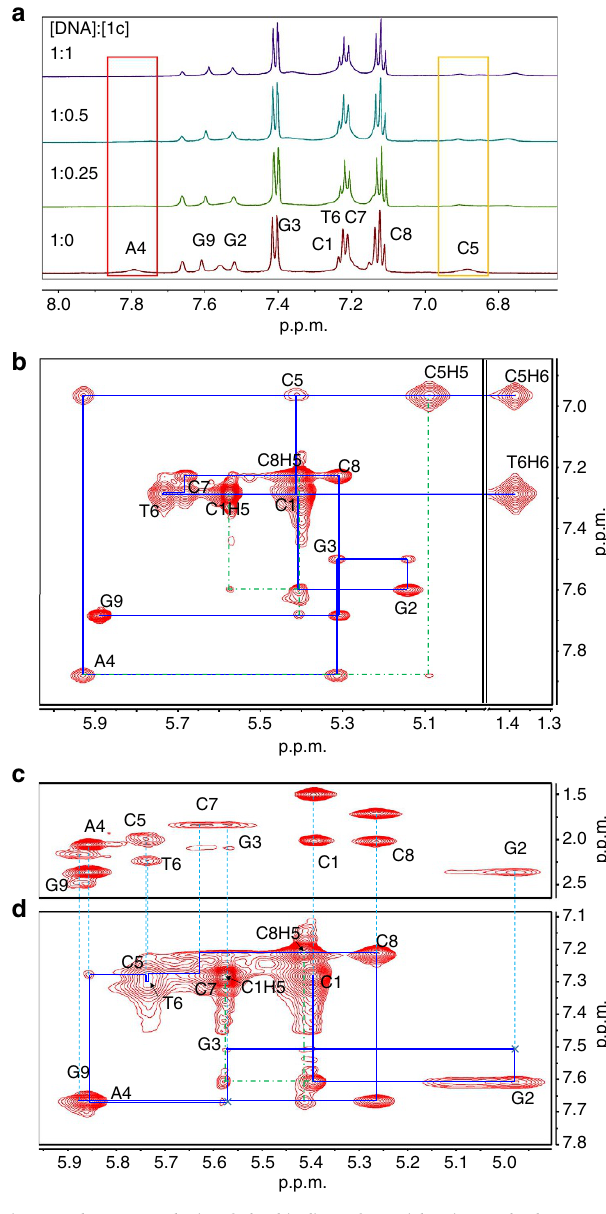
Figure 4 | NMR analysis of the binding of 1c with mismatched DNA. ( a ) 1 H NMR (phosphate buffer ¼ 50mM, pH 6.1, NaCl ¼ 20mM, in D 2 O, 10 (cid:2) C) spectra of a DNA oligonucleotide in the presence of different amounts of 1c . ( b ) 2D H1 0 (cid:3) aromatic (left) and T(Me) (cid:3) aromatic (right) NOESY spectra of a DNA oligonucleotide in phosphate buffer (50mM in D 2 O, containing NaCl ¼ 20mM, 10 (cid:2) C); a sequential NOESY walk along the full strand was identified. ( c ) TOCSY spectrum of H1 0 (cid:3) H2 0 –H2 00 and ( d ) NOESY spectrum of H1 0 (cid:3) aromatic of a DNA oligonucleotide in the presence of an equimolar concentration of 1c in phosphate buffer (50mM in D 2 O, containing NaCl ¼ 20mM, 10 (cid:2) C). We also found a sequential NOESY walk that was significantly different at A4 and C5 in comparison with DNA only in b , suggestive of interactions of 1c at a mismatched site. Note that the interactions of C1H5 with G2H8 and C8H5 with G9H8 at the terminal sites in b and d , and the interaction of C5H5 with A4H8 at the mismatched site in b were Supplementary Fig. 14 and described in Supplementary Table 1, showing an intramolecular Pt–Pt distance of 3.201 Å) was observed to display higher selectivity towards hairpin CC